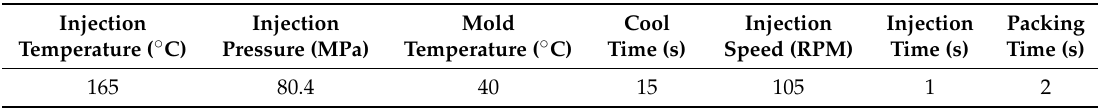
Table 5. Injection molding parameter for F2